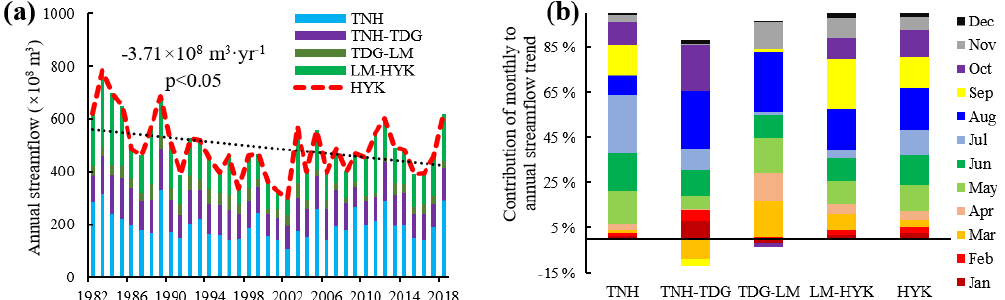
Figure 3. (a) Naturalized annual streamflows of HYK and different subregions, (b) contributions of the monthly to annual streamflow trend of HYK and different